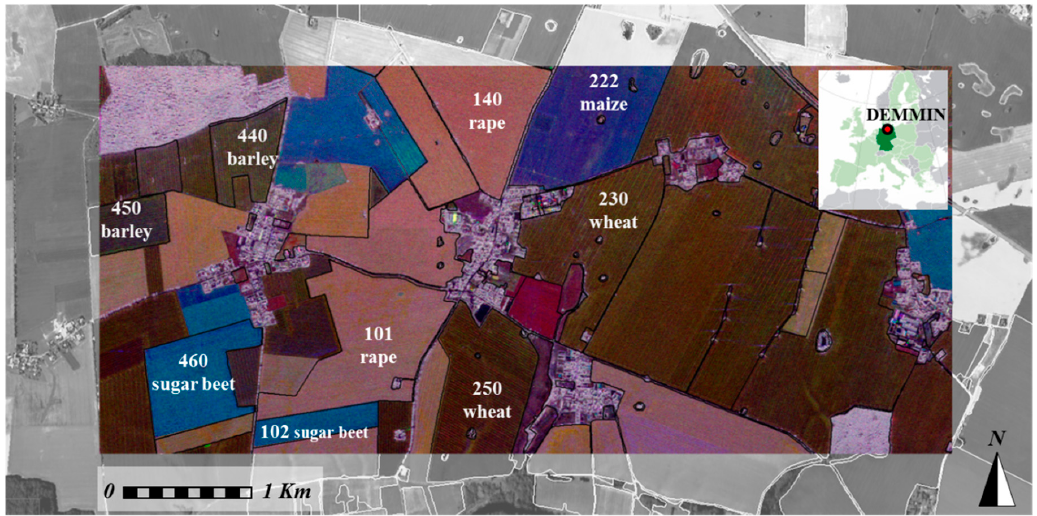
Figure 1. L HV diachronic composition of the DEMMIN test-area (R: 24 May; G: 21 June; B: 26 July). Labels indicating crop IDs and cultivars are over-imposed.